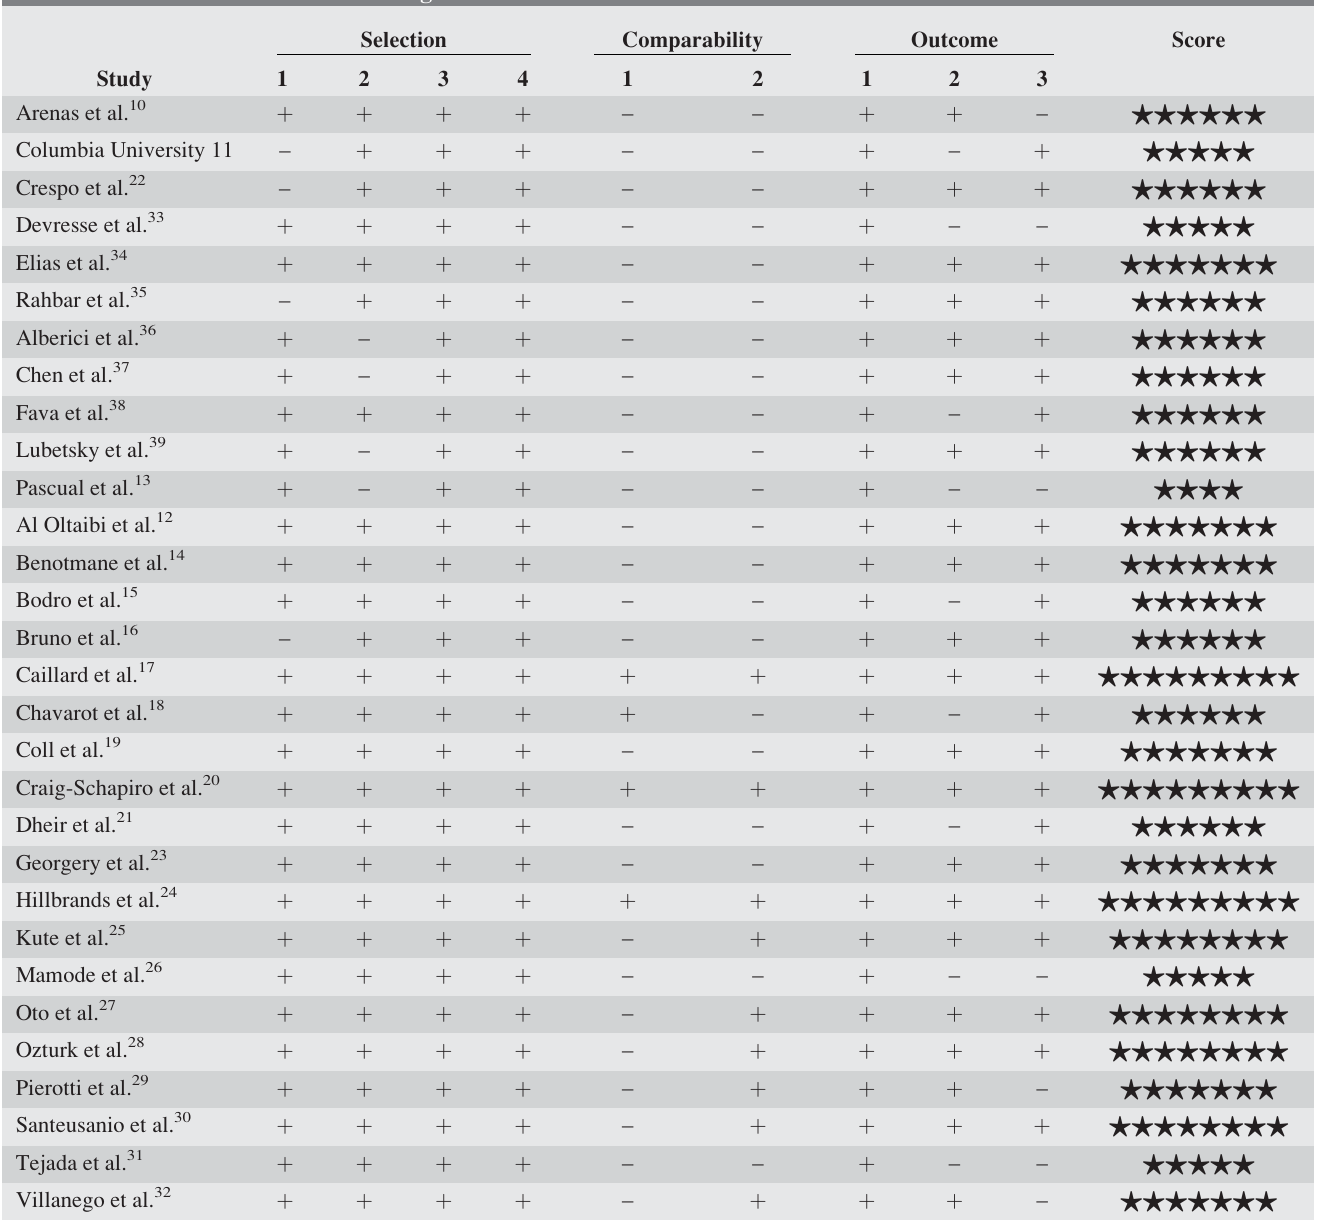
Table 3. Risk of Bias Assessment Using Newcastle-Ottawa